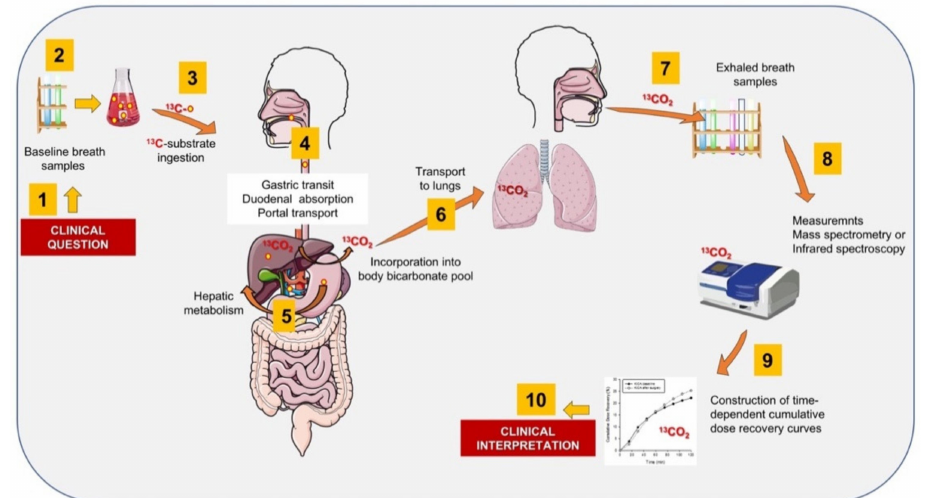
Figure 4. The ten-step protocol for the breath analysis using 13 C-substrates for the study of liver function. Starting from the clinical question (1), the fasting subject collects breath samples (2), and, after ingestion of the solution containing the substrate (3), further steps include gastric emptying, duodenal absorption, and portal transfer to the liver (4). The substrate undergoes metabolization at different levels (i.e., microsomes, cytosol, and mitochondria) with production of 13 CO 2 (5). Afterwards, 13 CO 2 undergoes incorporation into the bicarbonate pool and quick transport to the lung (6) where appears in exhaled air ready for collection (7). Breath samples are measured by infrared spectroscopy or mass spectrometry (8) with software constructing time-dependent curves of the metabolic process (9). The information serves to elaborate the specific clinical interpretation of liver function (10). An important assumption is that gastric emptying is not severely delayed and that the lung function is not severely impaired [96,143,145,158]. Cartoon adapted from Di Ciaula et al., Eur. J. Internal Medicine 2021